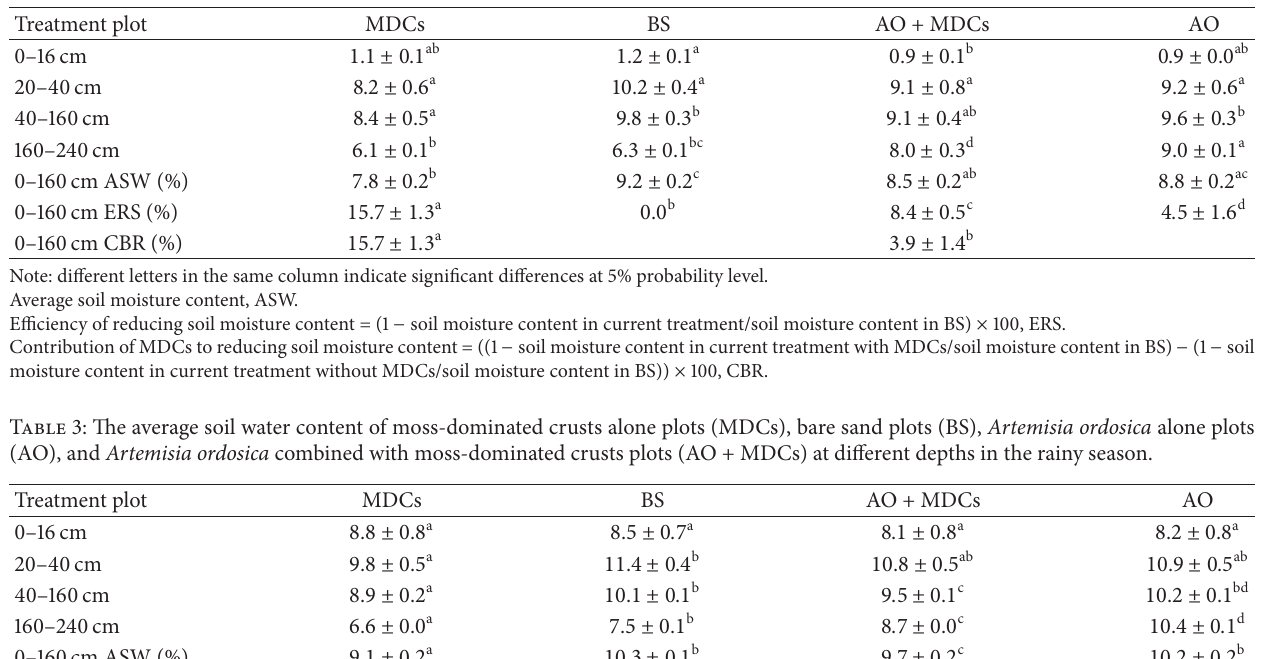
Table 2: Average soil water content of moss-dominated crusts alone plots (MDCs), bare sand plots (BS), Artemisia ordosica alone plots (AO), and Artemisia ordosica combined with moss-dominated crusts plots (AO + MDCs) at different depths in the dry season. Treatment plot MDCs